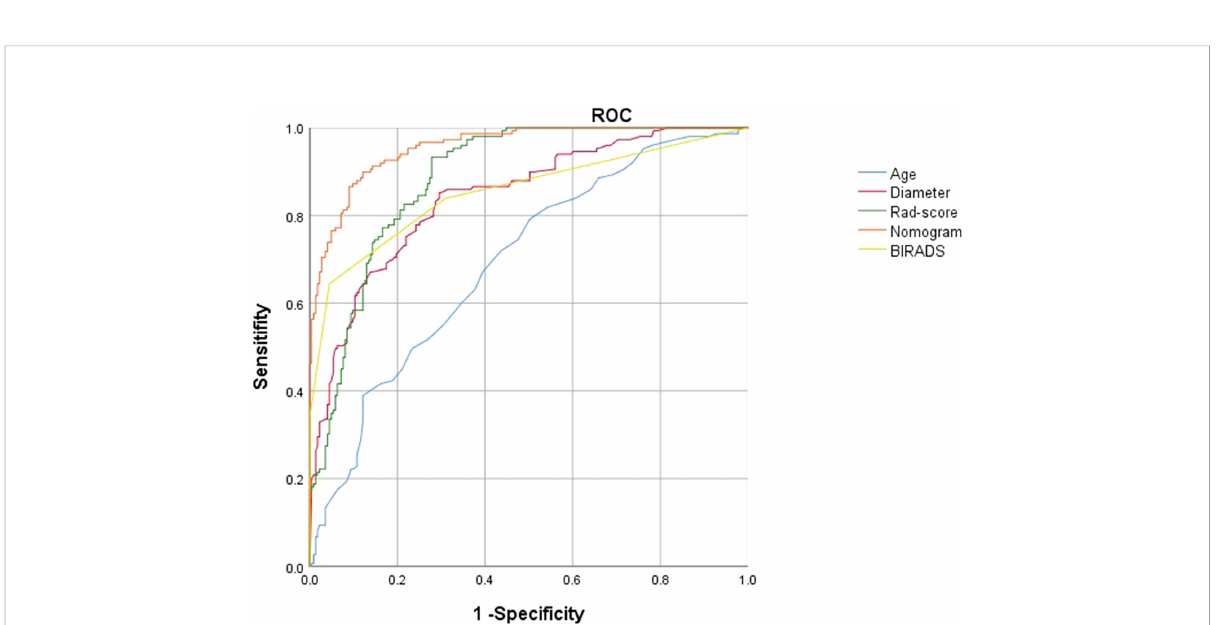
FIGURE 7 ROC curves of the radiomics score (green lines), BI-RADS category (yellow lines),patient age(blue lines),largest lesion diameter (red lines) and nomogram (orange lines) in the development